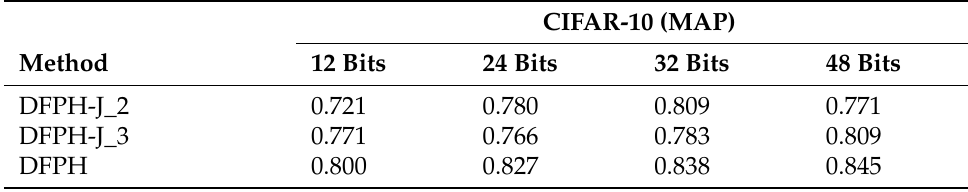
Table 6. MAP values of different variants of our objective function for CIFAR-10 data set.